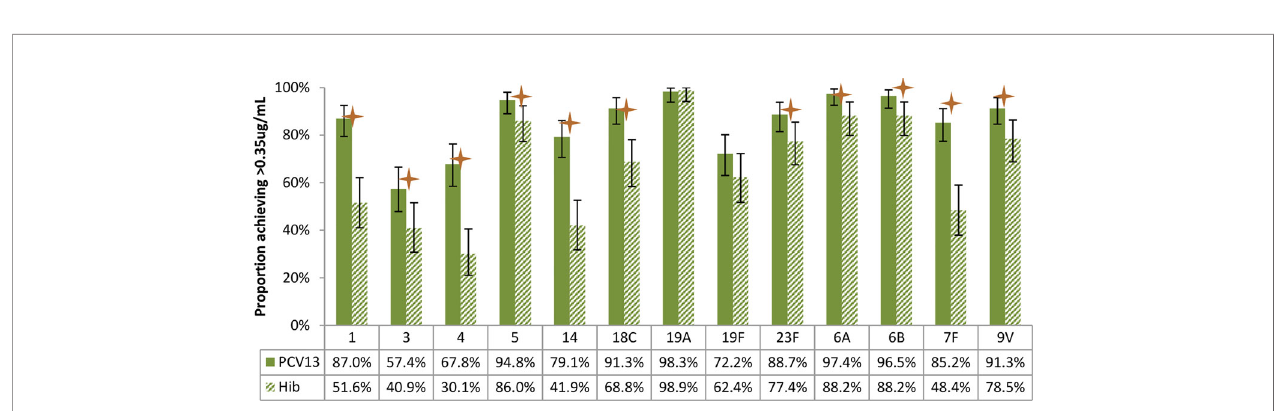
FIGURE 5 | Post-vaccination (about 3 months after 2 doses) proportions of participants with more than putative protective antibody concentration (0.35ug/mL), by study arm. Statistically higher proportion of participants achieving putative protective antibody concentration in PCV13 vaccinees for 11 of the 13 vaccine serotypes (1, 3, 4, 5, 14, 18C, 23F, 6A, 6B, 7F, 9V) (star symbols over bars indicate statistical signi fi